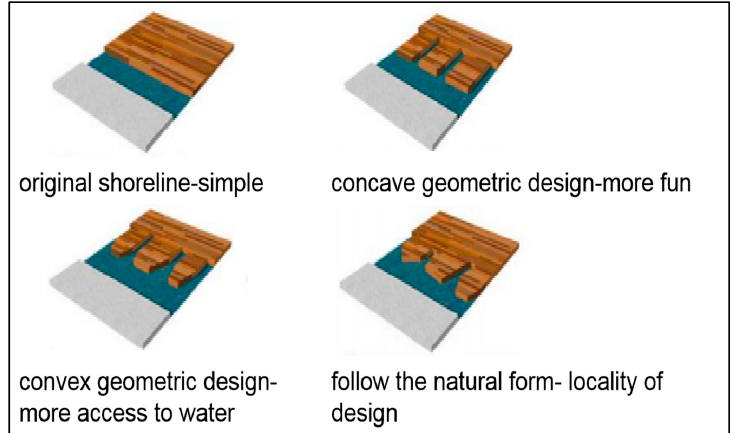
Figure 6. Plans of green-way and blue-way systems in Pu’an village.